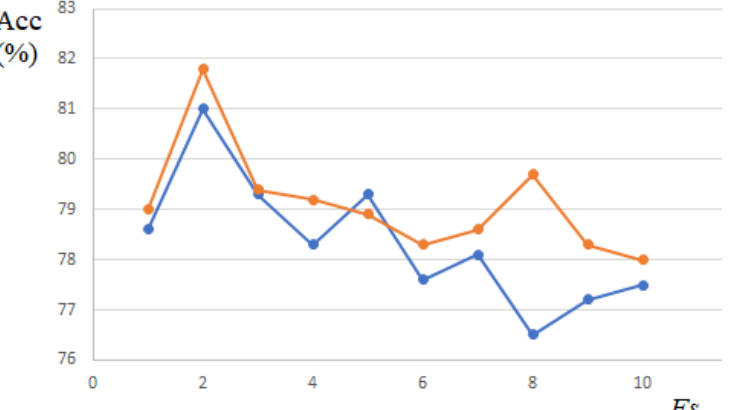
Figure 4. Testing accuracy obtained by different filter sizes, for English ( red ) and Italian ( blue ).